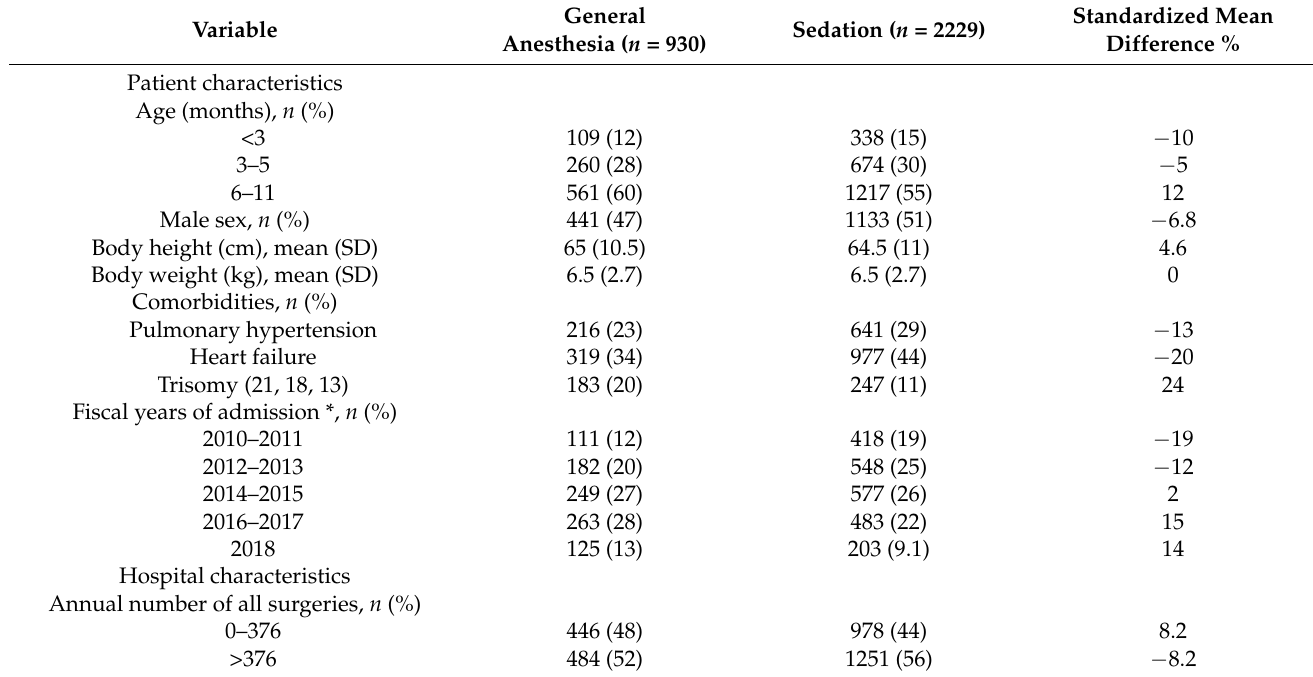
Table 1. Baseline characteristics of all eligible patients before adjustment.